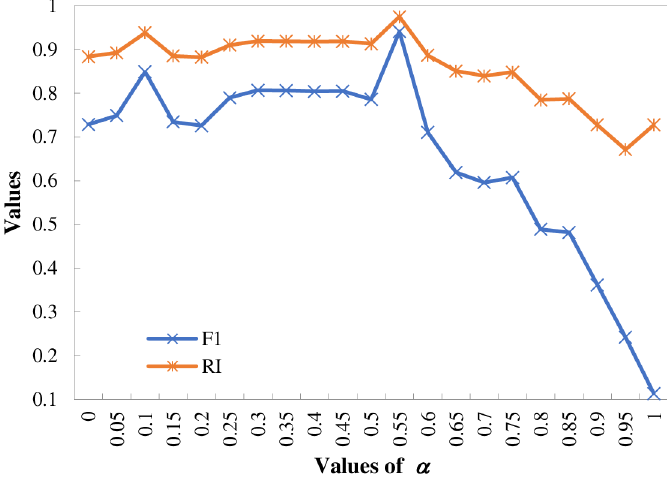
Fig 4. Values of F1 measureand RI with different values of parameter α